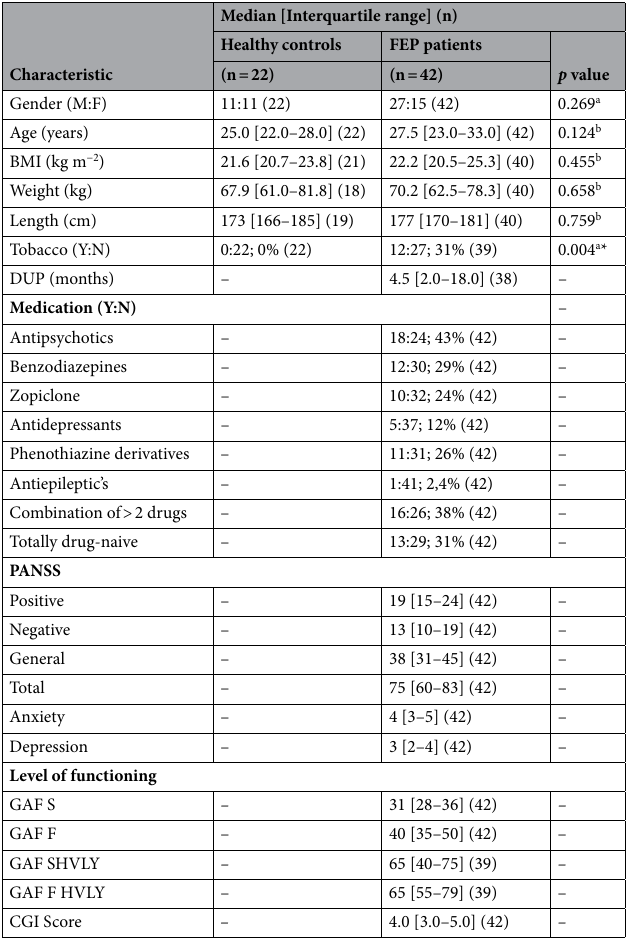
Table 1. Demographic and clinical characteristics of the study population. Abbreviations : FEP, first-episode psychosis; M:F, Male:Female; Y:N, Yes:No; (n), number; BMI, body mass index; DUP, Duration of untreated psychosis; PANSS, Positive and Negative Syndrome Scale; GAF S, Global Assessment of Functioning Symptoms; GAF F, Global Assessment of Functioning Functions; HVLY, highest value last year; CGI,